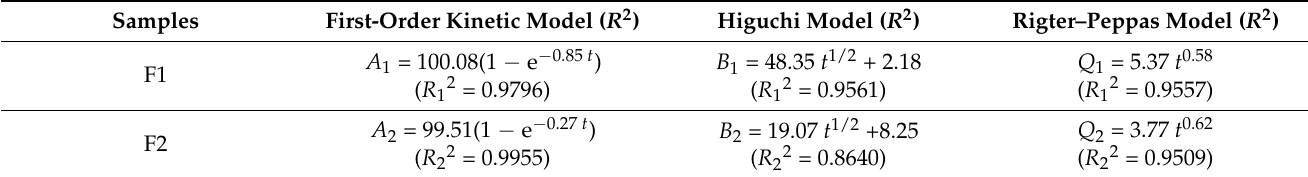
Table 1. Mathematical model analysis of drug release data for prepared fibers. Samples